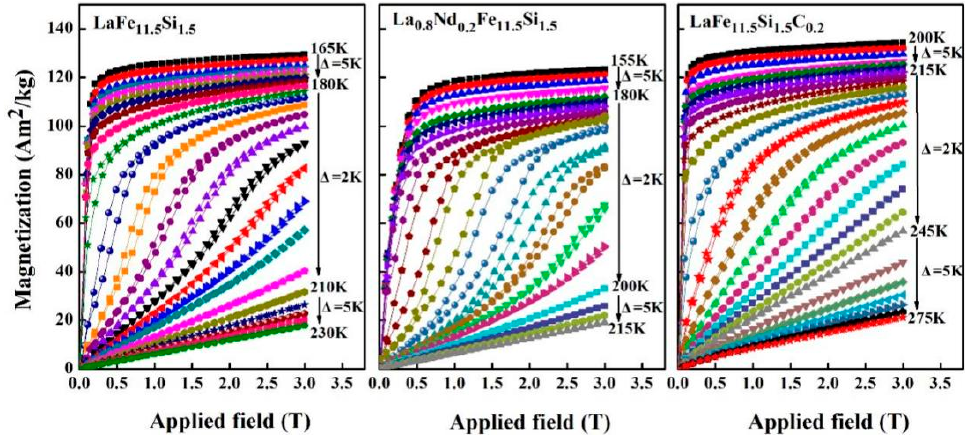
Figure 3. Magnetization isotherms of LaFe 11.5 Si 1.5 , La 0.8 Nd 0.2 Fe 11.5 Si 1.5 , and LaFe 11.5 Si 1.5 C 0.2 . Tempera-